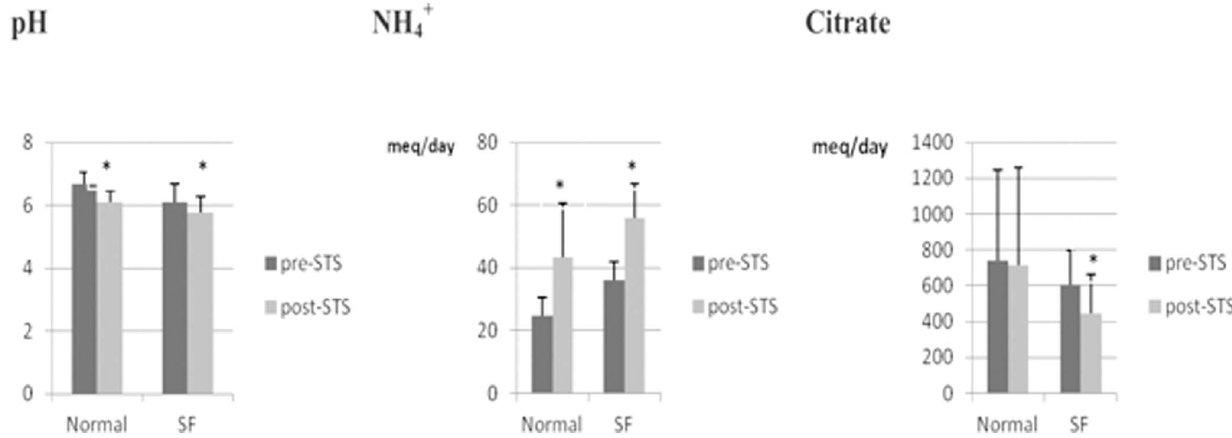
Figure 2. Comparison of pre- and post-STS urine pH, ammonium and citrate excretion in normal (n=5) and hypercalciuric (n=5) stone formers (*: P , 0.05 post-STS compared with pre-STS).